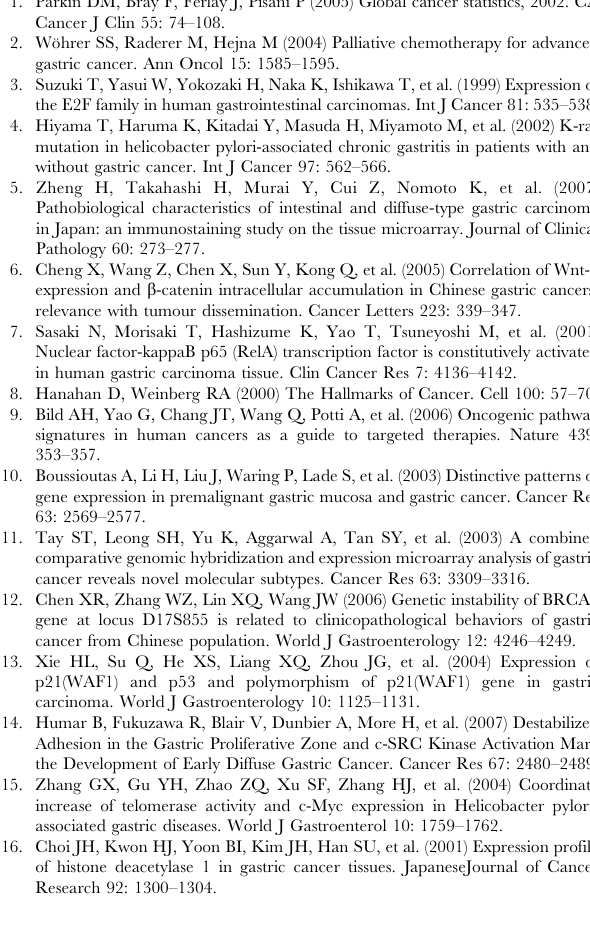
Table S10 Histopathological data for Cohort 3 of 31 tumors from the United Kingdom.